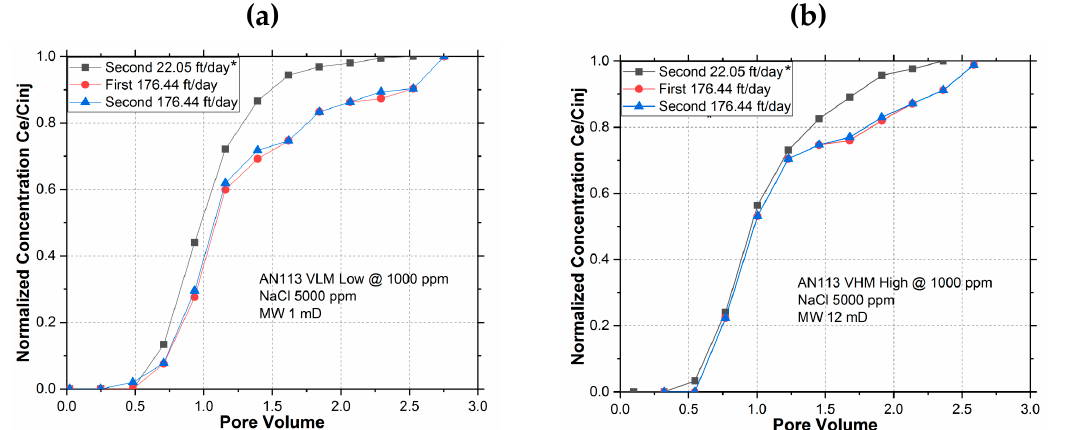
Figure 7. Polymer Hydrodynamic Retention Reversibility for ( a ) AN 113 VHM and ( b ) AN 113 VHM. * The “Second 22 ft/day” breakout curve was determined in earlier experiments. It represents no adsorption case, hence is usable as the reference slug to determine the area between the curves for all subsequent breakout curves including the first and second 176 ft/day breakout curves shown in this figure.